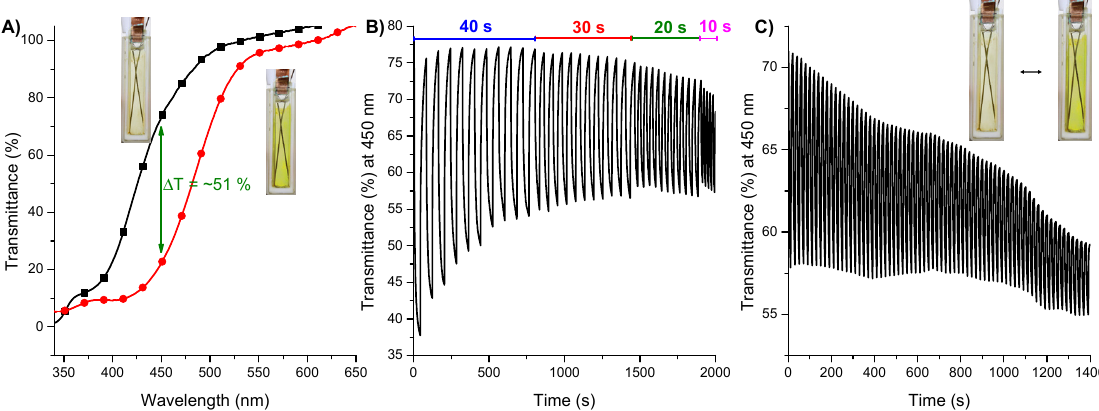
Figure 8. ( A ) The transmittance spectra of the poly-1 in oxidized (black) and reduced (red) form; ( B ) Electrochromic switching between oxidized and reduced form of poly-1 with intervals of 40, 30, 20 and 10 s monitored at 450 nm; ( C ) The Transmittance difference of poly-1 by switching between oxidized and reduced states with 10 s intervals.